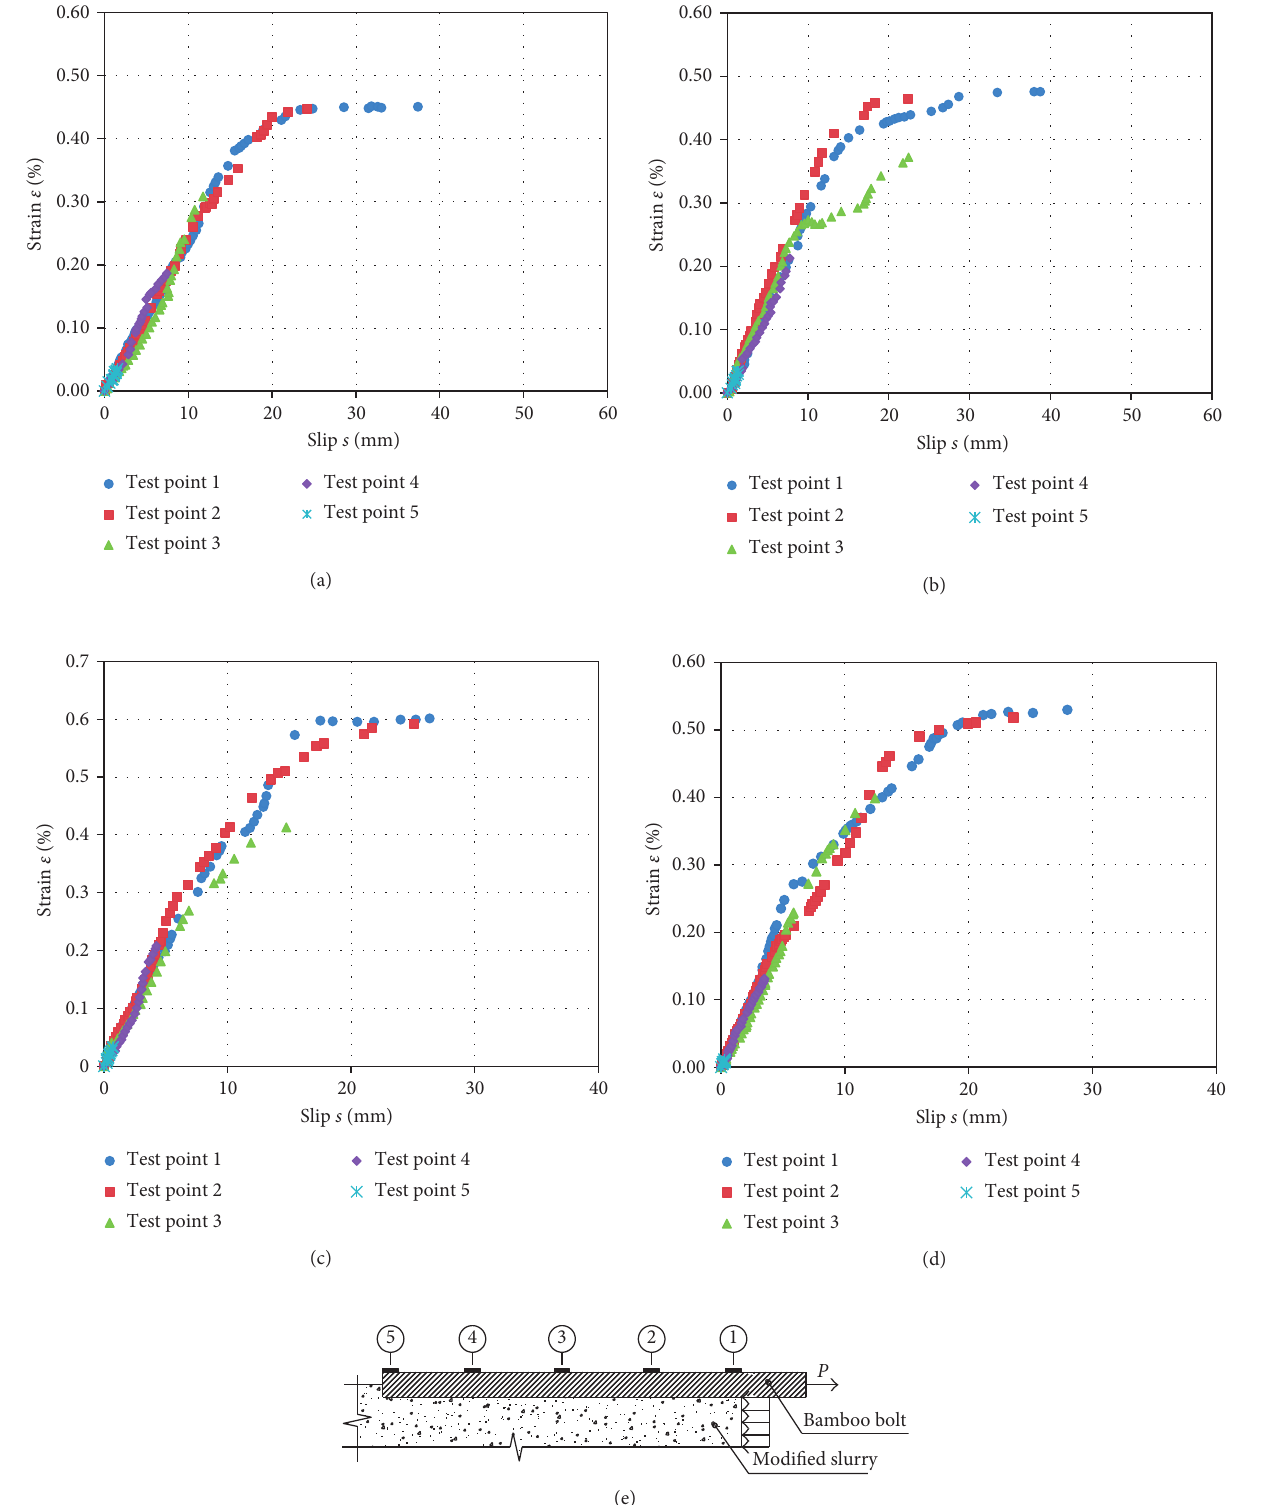
Figure 16: Microsection strain-slip curve of bamboo bolt-modified slurry interface ( L 3000a. (d) CB-L-3000b. (e) Strain gauge distribution on bamboo bolt